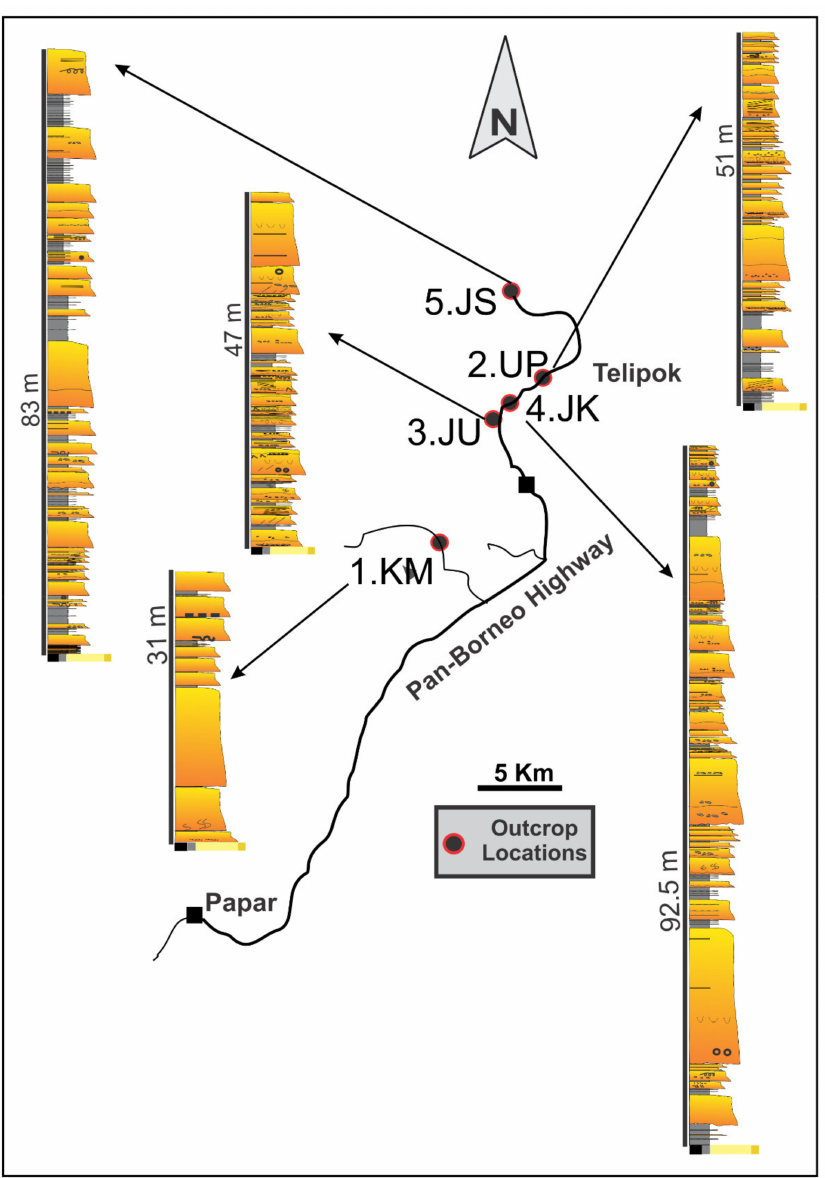
Figure 3. Stratigraphic distribution of the selected exposed outcrops that represent the multiscale sand–shale complex system. These lithological heterogeneities are interpreted as various components of the submarine fan–lobe